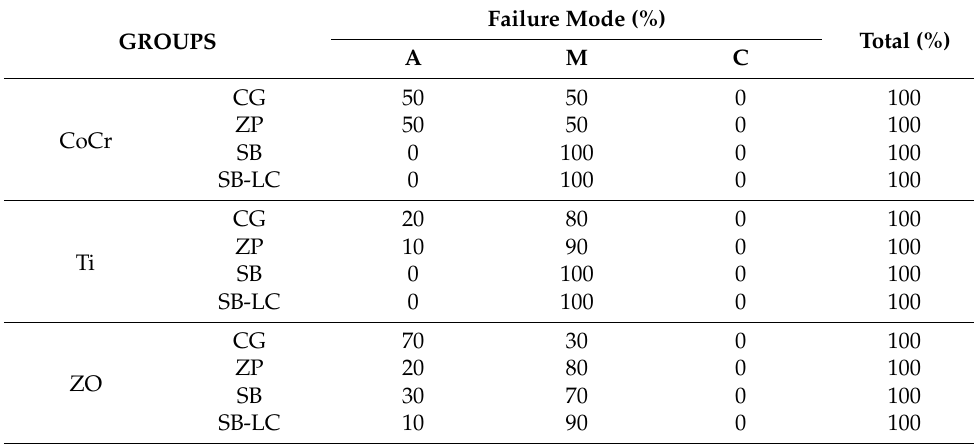
Table A4. Failure mode (%) of specimens upon shear bond strength